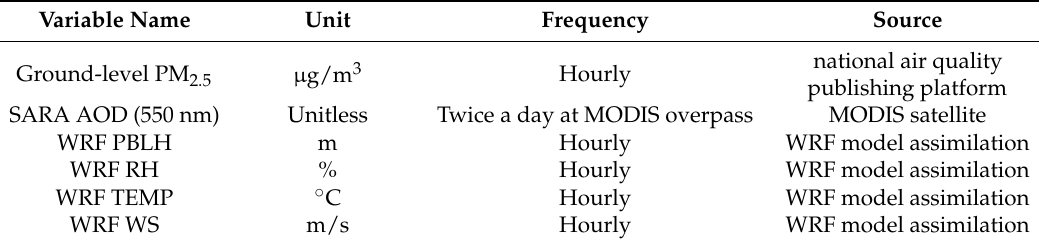
Figure 4. Flowchart of the proposed GTWR method for estimating hourly PM 2.5 at 500 m resolution. Table 1. A summary of data variables used in the GTWR model.